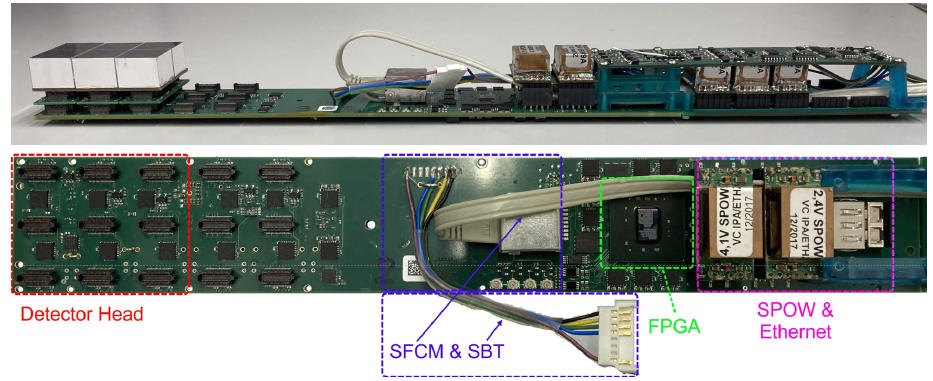
Figure 9. The SDIP. The upper image depicts the full casket assembly (side view), including the detector head on the left, as well as the SSPD and SBT PCB’s on the right. Below is a birds-eye-view of the SDIP itself. Central component is a Kintex-7 FPGA (marked in green), connected to the DHMs via SAMTEC connectors (red), the SFCM and SBT via cabling (blue), and the DAQ system via an SFP module located under SPOWs